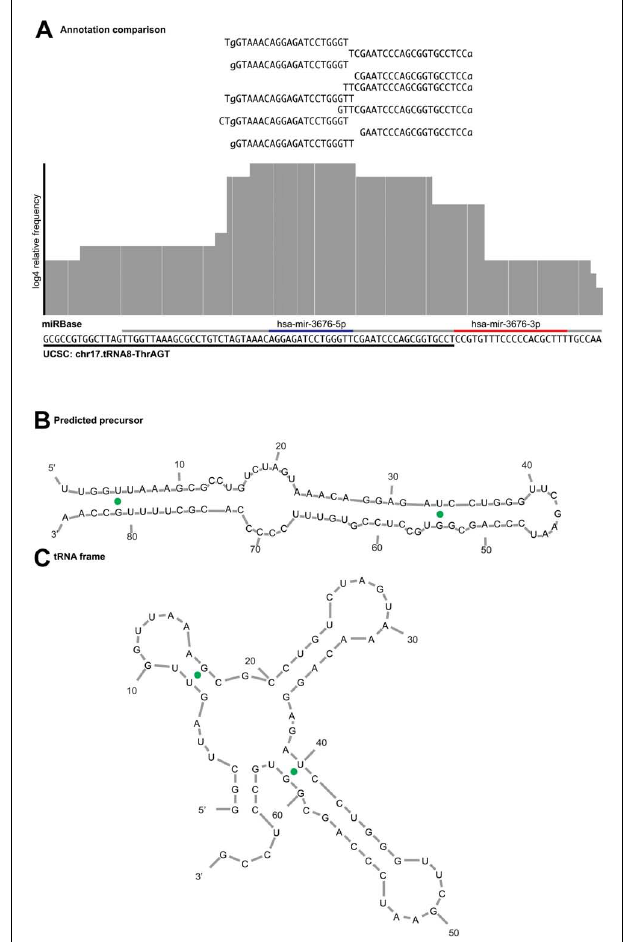
FIGURE 5 | Example of read alignment diagram for a miRNA not meeting the acceptance criteria. (A) A similar view to Figure 3 for putative mir-3676, including reads that map with one error distance to the precursor. Underlined in gray is the purported miRNA precursor, with the annotated mature and star sequences highlighted in blue and red, respectively. Underlined in black is the sequence annotated as tRNA pseudogene in the UCSC genome browser.The read evidence clearly supports a tRNA biogenesis pattern as the top reads map to that of the tRNA CCA 3 (cid:2) terminus, rather than the bimodal distribution expected from a prototypical miRNA. (B) Predicted miRNA structure shows that the 5 (cid:2) arm is shorter than what is expected for a mature miRNA product and does not produce the expected overhang. (C) If the sequence frame is shifted, the secondary structure prediction demonstrates a fold commensurate with that of a